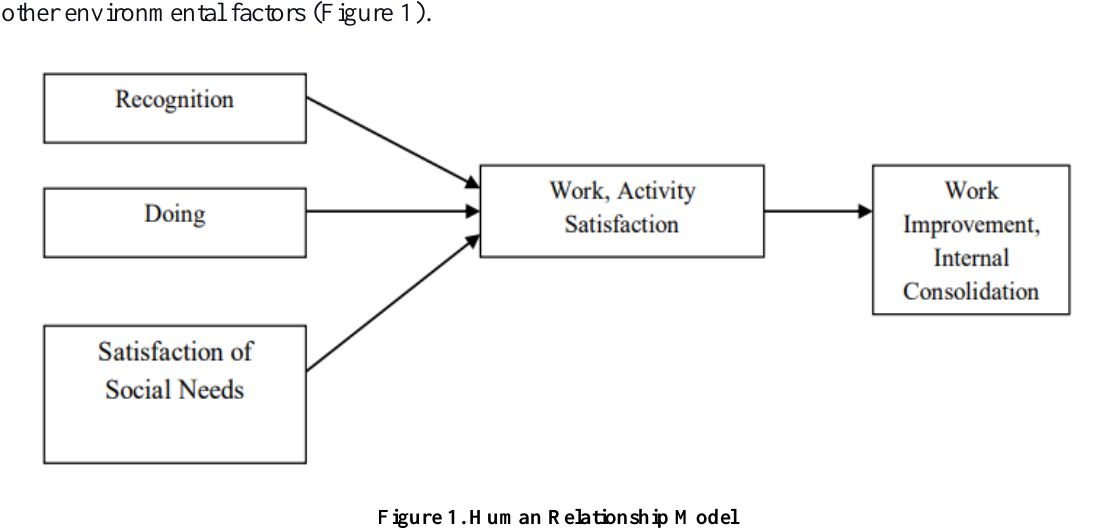
Figure 1. Human Relationship